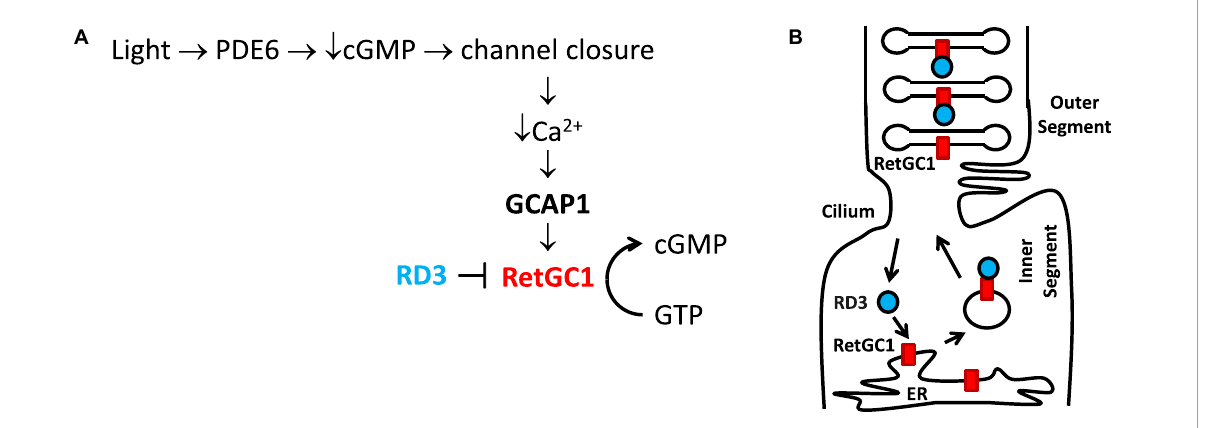
FIGURE1 Physiological role of GCAP1 and RD3 in visual phototransduction. Adapted from Ames (2019). (A) Visual excitation pathway in retinal photoreceptor cells. Light-activated channel closure promotes a drop in cytosolic Ca 2 + level that in turn causes Ca 2 + -free/Mg 2 + -bound GCAP1 to bind and activate RetGC1. RD3 binding to RetGC1 inhibits the cyclase activity. (B) RD3 (cyan) guides the trafficking of RetGC1 (red) to outer segment disk membranes.